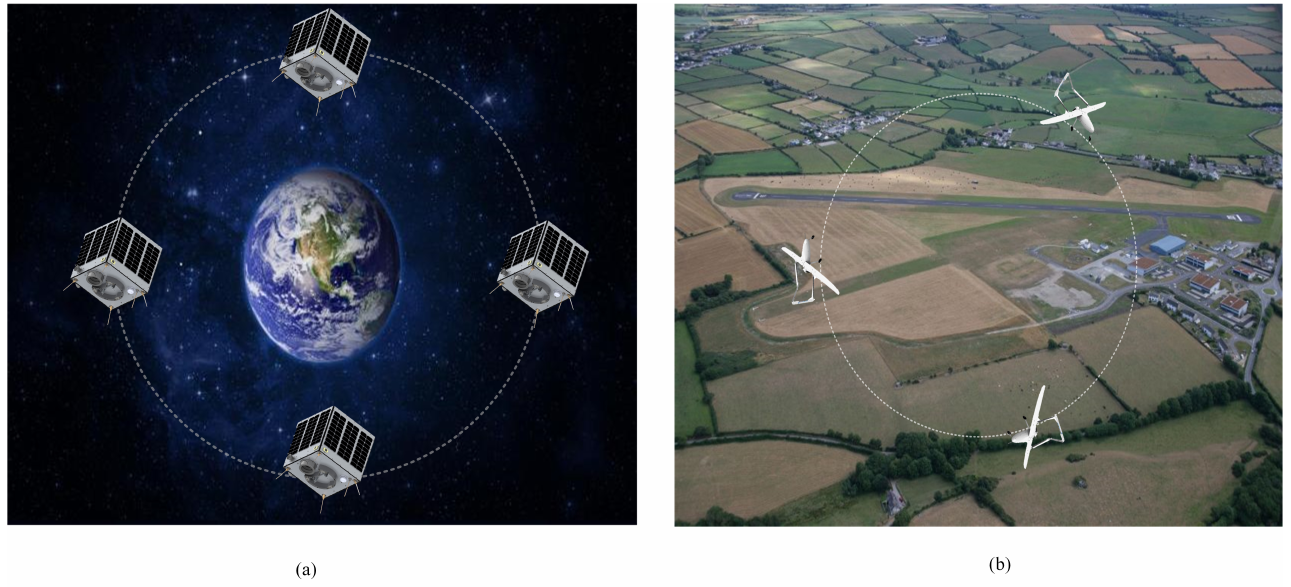
Figure 8. Circular formation applications: ( a ) group of micro-satellites orbiting around Earth; ( b ) group of UAVs surveillance and navigation